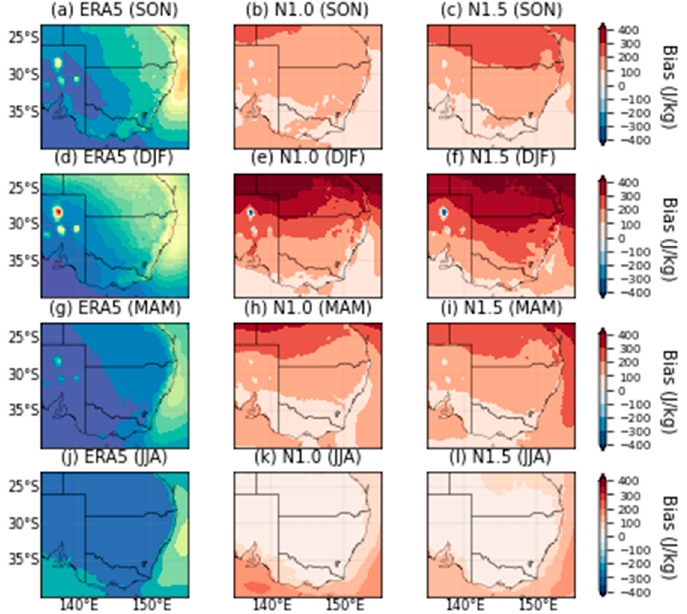
Figure A16. Climatology of MUCAPE in d02 from ( a , d , g , j ) ERA5; biases ii ( b , e , h , k ) N1.0 and ( c , f , i , l ) N1.5 during SON (row 1), DJF (row 2), MAM (row 3) and JJA (row 4). The colorbar for climatology is as in Figure A15. Unit: J kg − 1 .